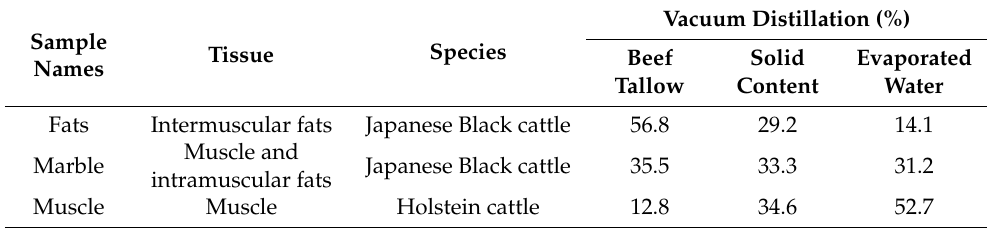
Table 1. Low-temperature vacuum extraction of beef tallow using a water ejector vacuum dryer.